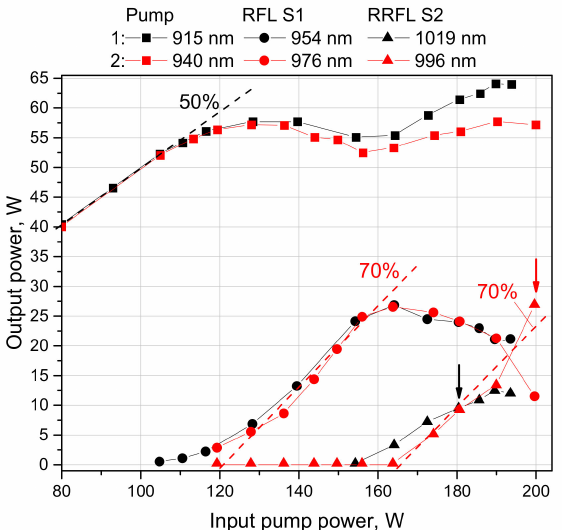
Figure 5. Transmitted pump power (squares) and output power for the 1st Stokes, S1 (circles), and 2nd Stokes, S2 (triangles), as a function of the input pump power from multimode LDs in two configurations: 915 nm LD/954 nm RFL S1/996 nm RRFL S2 (red) and 940 nm LD/976 nm RFL S1/1019 nm RRFL S2 (black). Arrows mark corresponding 3rd Stokes